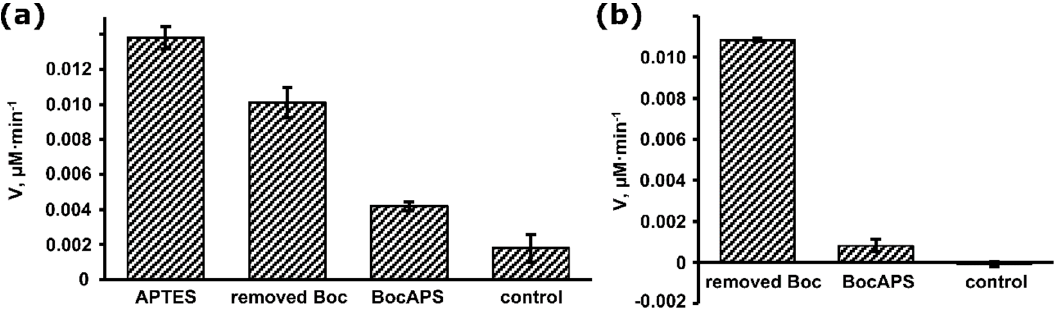
Figure 5. The activity of glucose oxidase immobilized on silicon slides using BocAPS. Chemical deprotection ( a ), electrochemical deprotection ( b ).